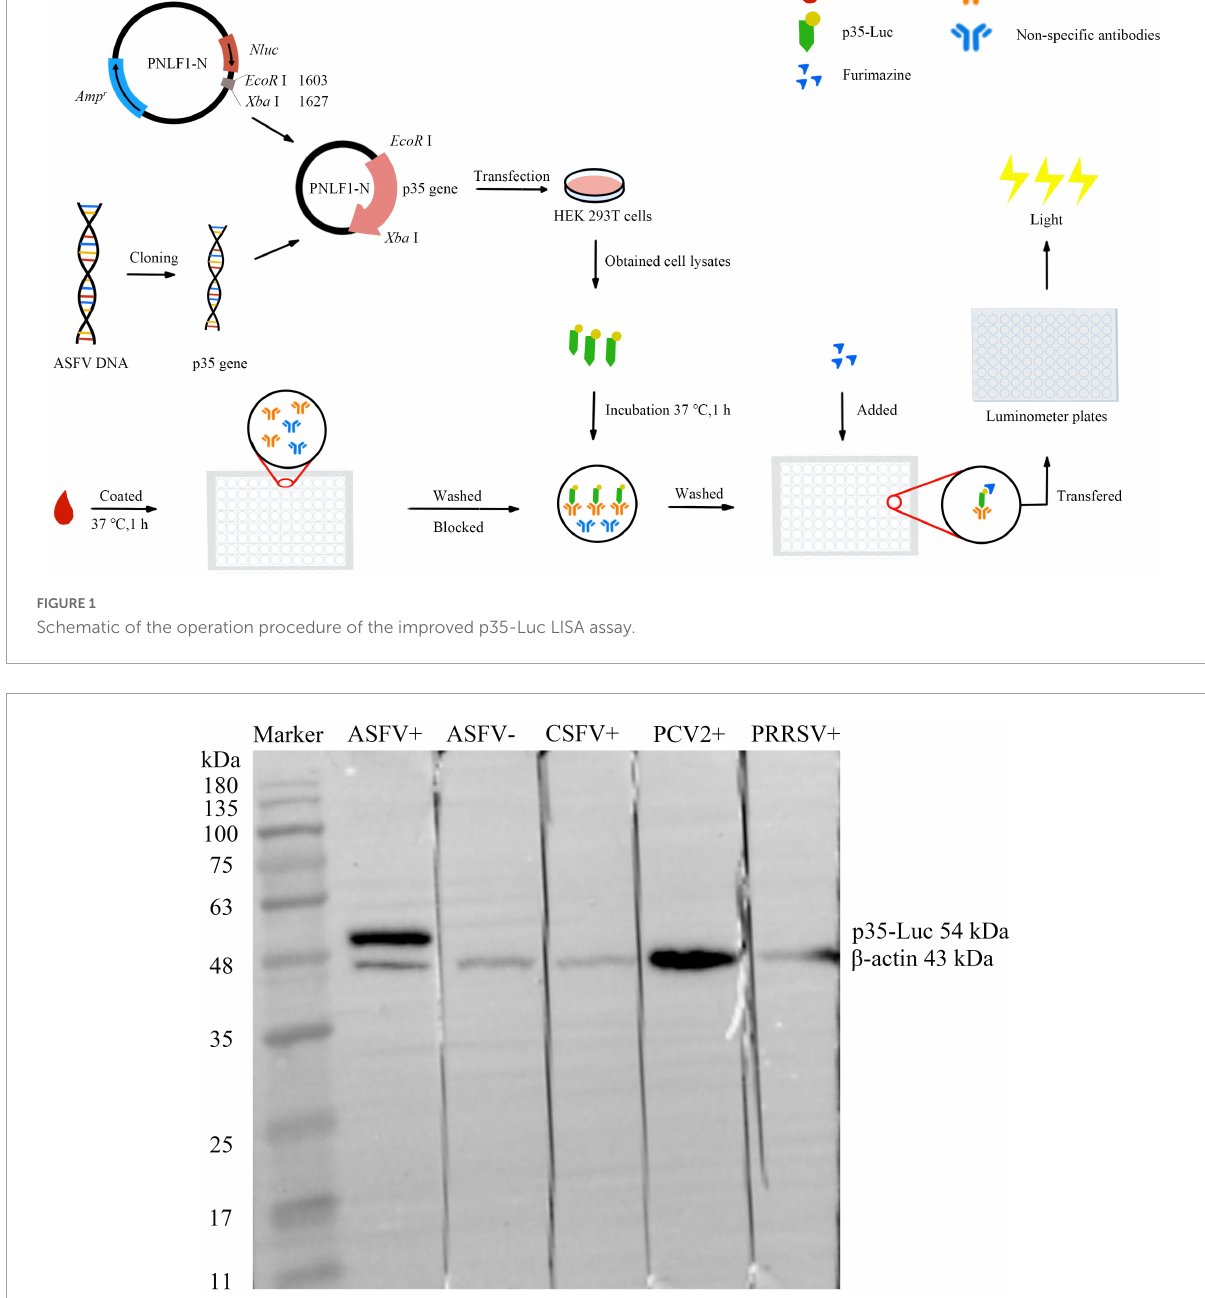
through analyzing the receiver operating characteristic (ROC) curve and degree of agreement (kappa value) of a panel of inactivated ASFV-positive and -negative serum samples. All